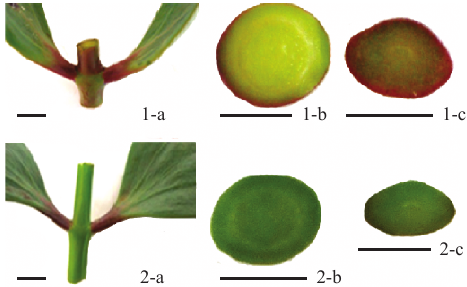
Fig. 2 - Sections of stems (1-a, b) and petioles (1-c) of Kalanchoe brasiliensis seedlings under full sunlight and 25% of light (stem: 2-a, b; petiole: 2-c). Bars =